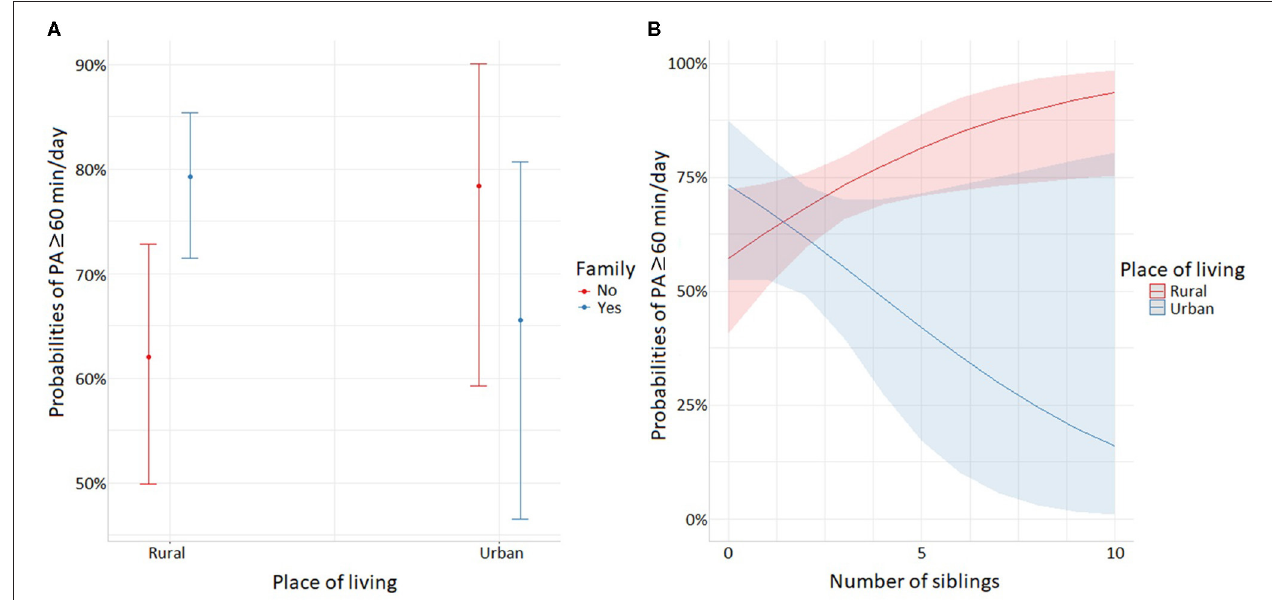
FIGURE 5 | Significant interactions for PA time: (A) interactions between place of living and family in female adolescents, (B) interactions between place of living and siblings in male adolescents.